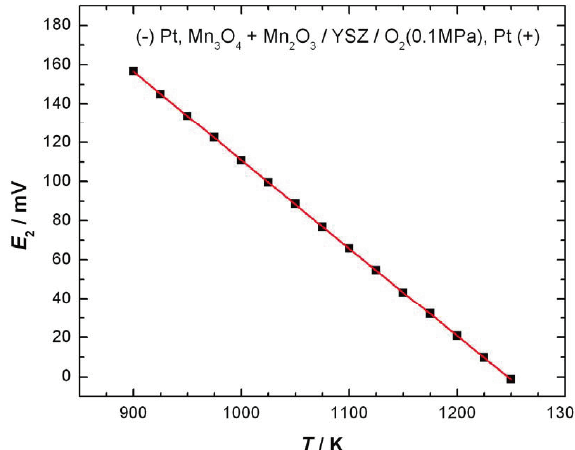
Figure 4. Temperature dependence of the emf of cell